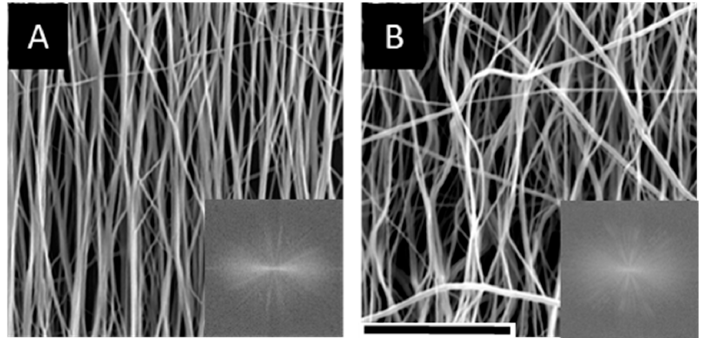
Figure 2. Representative scanning electron microscope (SEM) images of EFMs. Aligned ( A ) and tension-released ( B ) 100 µm thick EFMs showing differences in fiber morphology following release of internal tension. Insets: Fourier transform of the figure, indicating degree of alignment. Scale bar = 50 µm.